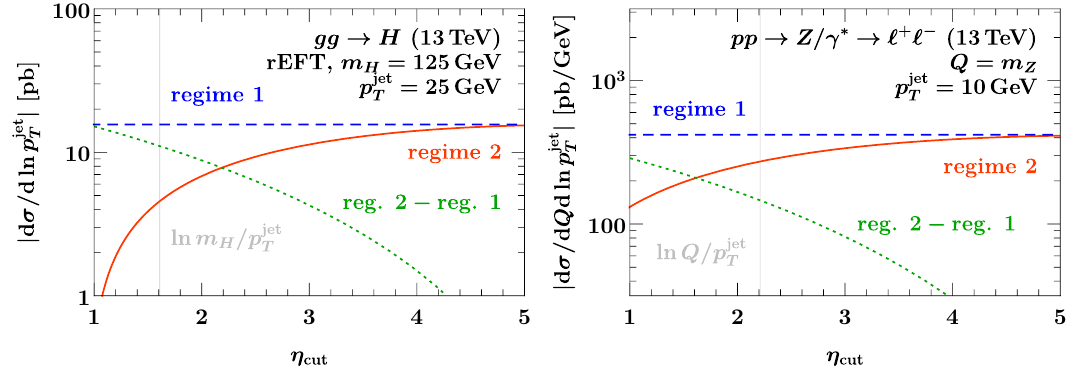
Figure 3 . Comparison of the singular contributions to the (cid:12)xed ( (cid:11) s ) (LO 1 ) p jet spectrum for T O gg H (left) and Drell-Yan (right). The orange solid lines show the singular contributions in ! regime 2 with (cid:17) cut dependent beam functions. The dashed blue lines show the singular contributions in regime 1 in the limit (cid:17) cut = , p cut Qe (cid:0) (cid:17) cut . Their di(cid:11)erence, shown by the dotted green lines, T (cid:29) 1 correctly scales as a power in Qe (cid:0) (cid:17) cut =p jet . The vertical lines indicate the point p jet = Qe (cid:0) (cid:17) cut T T